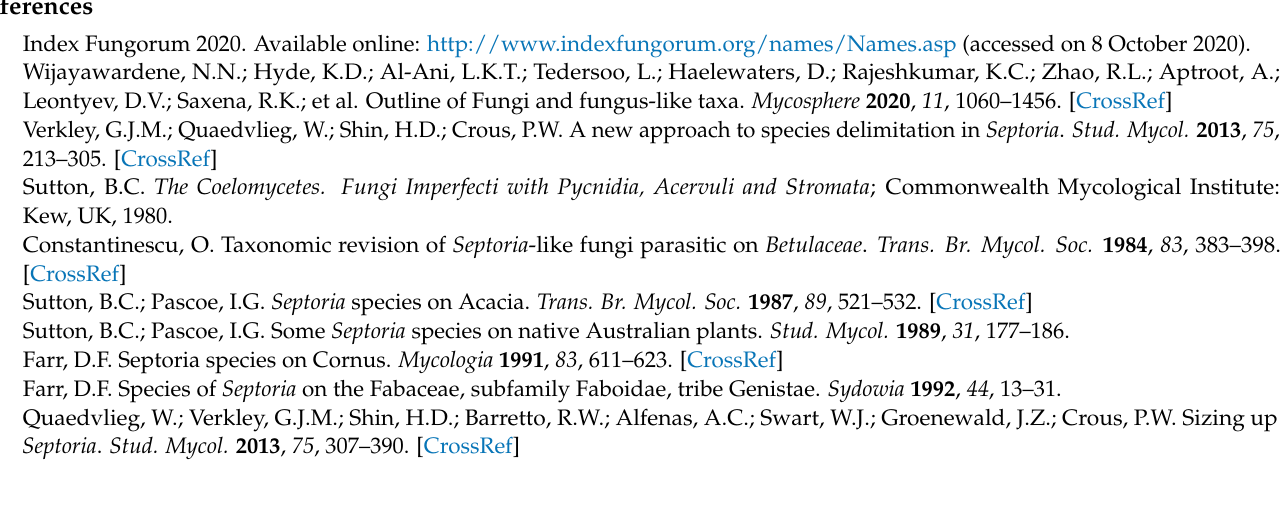
phylogenetic tree based on LSU region. Figure S3: The phylogenetic tree based on rpb2 region. Figure S4: The phylogenetic tree based on tef1 region. Figure S5: The phylogenetic tree based on tub2 region. Cercospora beticola (CBS 124.31) was used as outgroup taxon. MP and ML above 50% and BPP above 0.90 were placed close to topological nodes and separated by “/”, otherwise were labeled with “-”. Taxa from this study are highlighted in green. Table S1: DNA base difference between our Septoria strains and related